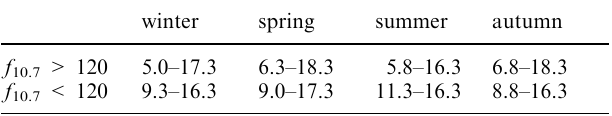
Table 5. Inversion time (in LT) in the morning and in the afternoon winter spring summer